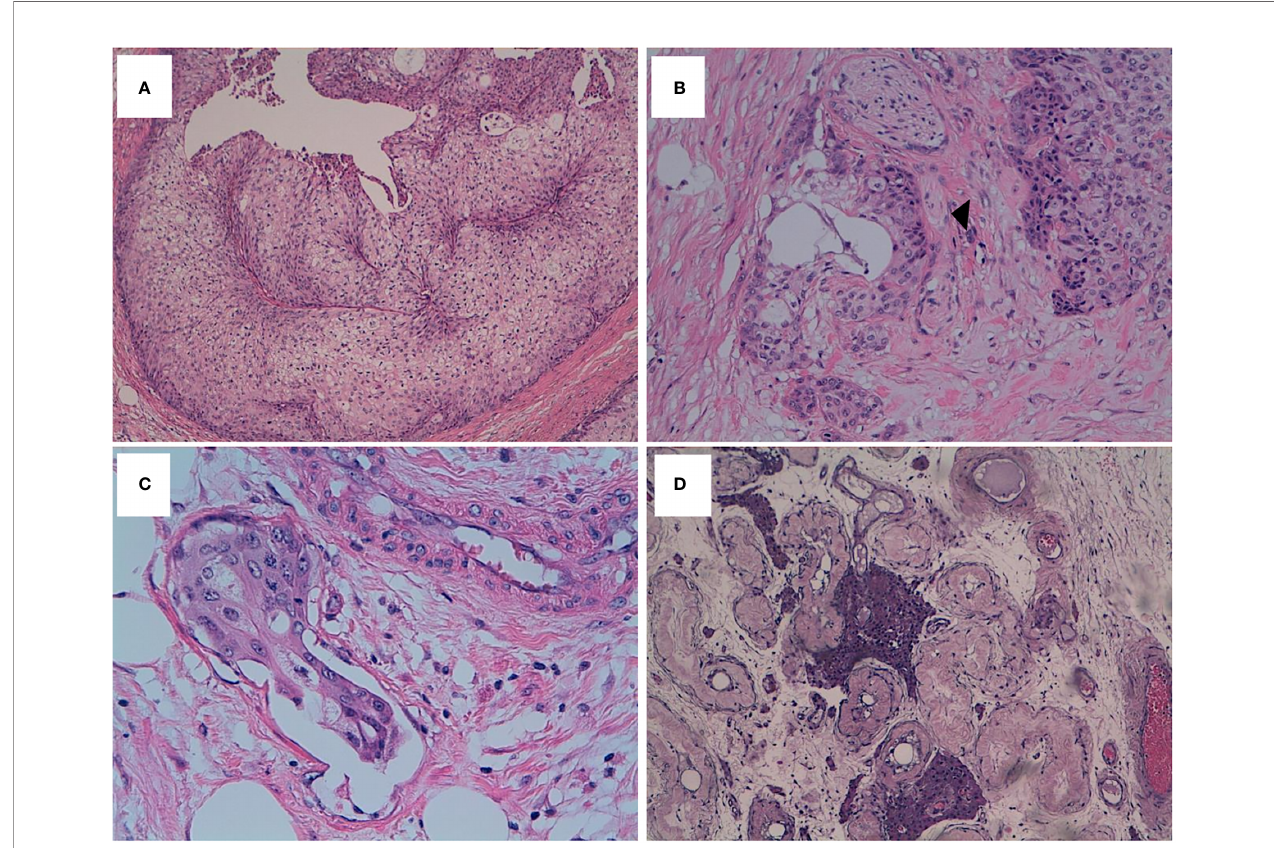
FIGURE 1 | mBT tissue stained with H&E. (A) Neoplatic cells resembling invasive urothelial carcinoma exhibit high mitotic activity (H&E, x10 magni fi cation). (B) Perineural ( head arrow ) in fi ltration (x20 magni fi cation). (C) Linfovascular invasion (x40 magni fi cation). (D) Testis showing tubular atrophy and Leydig cells hyperplasia (x10 magni fi